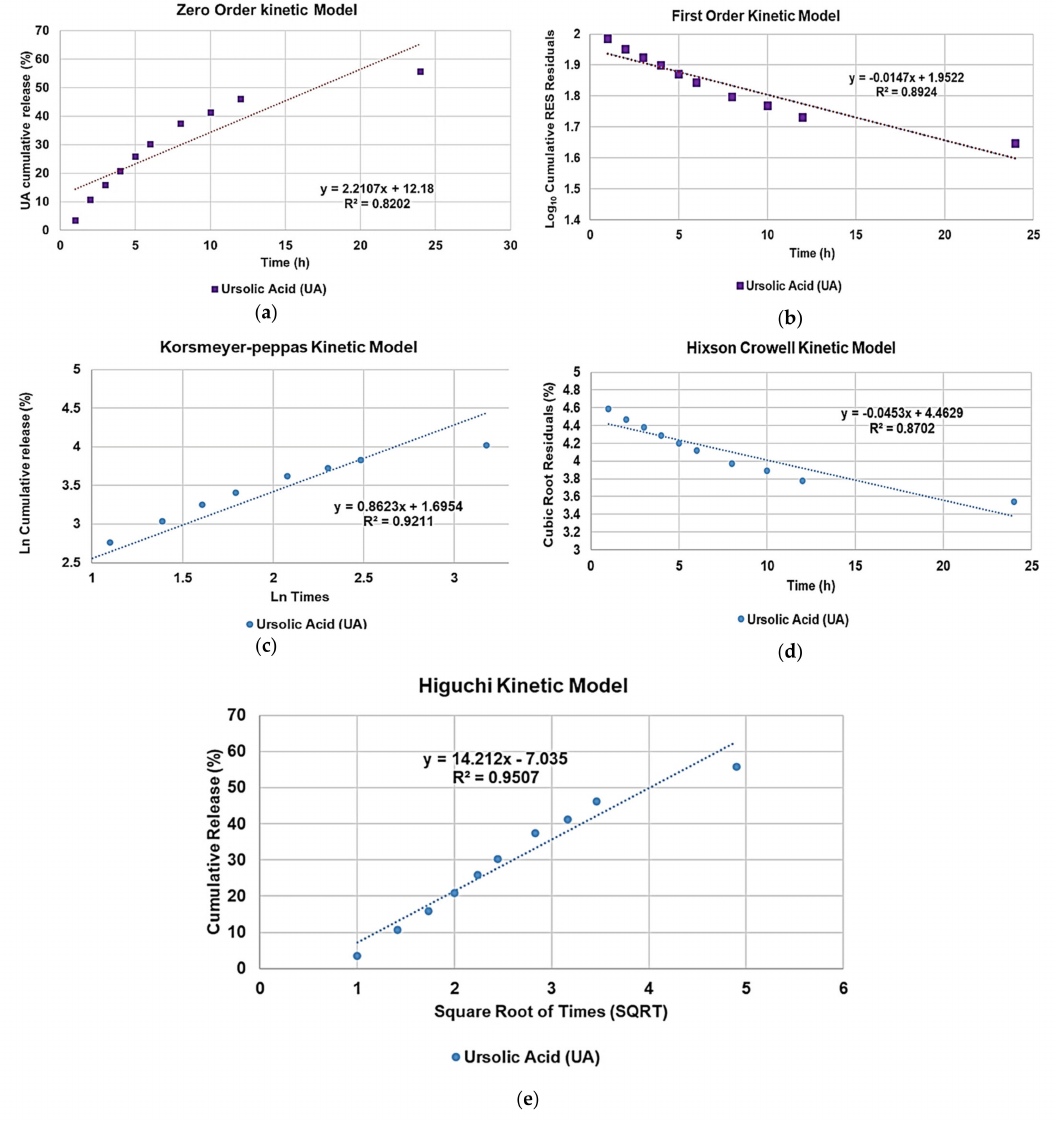
Figure 12. Linear regressions of kinetic mathematical models with the related equations and R 2 values. Zero order ( a ), first order ( b ), Korsmeyer–Peppas ( c ), Hixson–Crowell ( d ) and Higuchi ( e ) kinetic